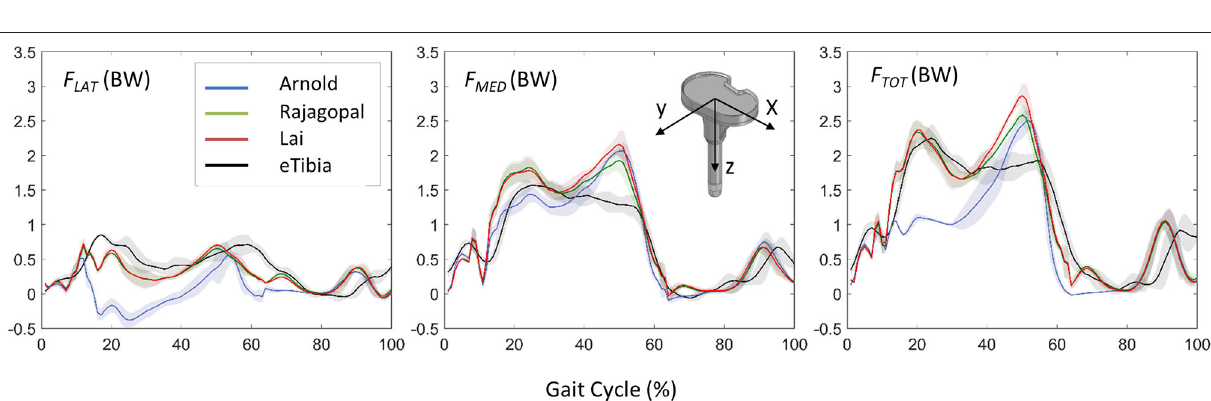
and knee joint force during level walking which can be used